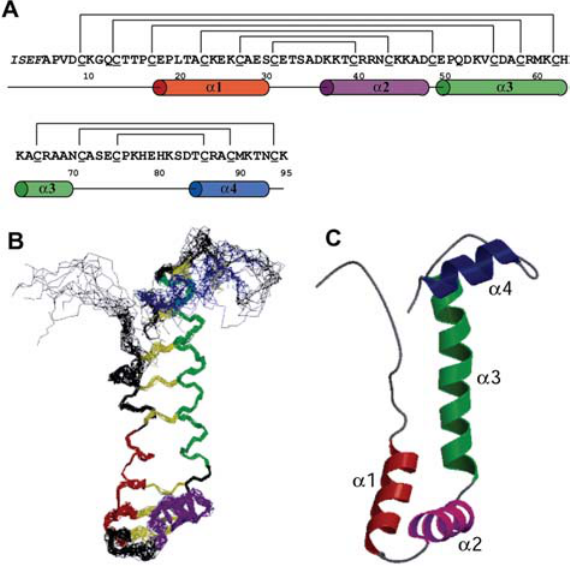
Figure 5 Structure of Vanabin2 from A. sydneiensis samea . (A) Amino acid sequence of Vanabin2. The amino terminal tag is italicized. Disulfide bond pairings, as determined by the CYANA calculation, are indicated at the top of the sequence. The secondary structure elements of Vanabin2 are indicated at the bottom of the sequence and are colored correspondingly in all panels. (B) The final 10 structures superposed over the backbone heavy atoms of residues 18–70. The side chains of the half-cysteine residues are shown as yellow lines. (C) Ribbon representation of a single struc- ture in the same orientation as in panel (B). Reproduced from Ref. (113). Copyright 2005 American Chemical